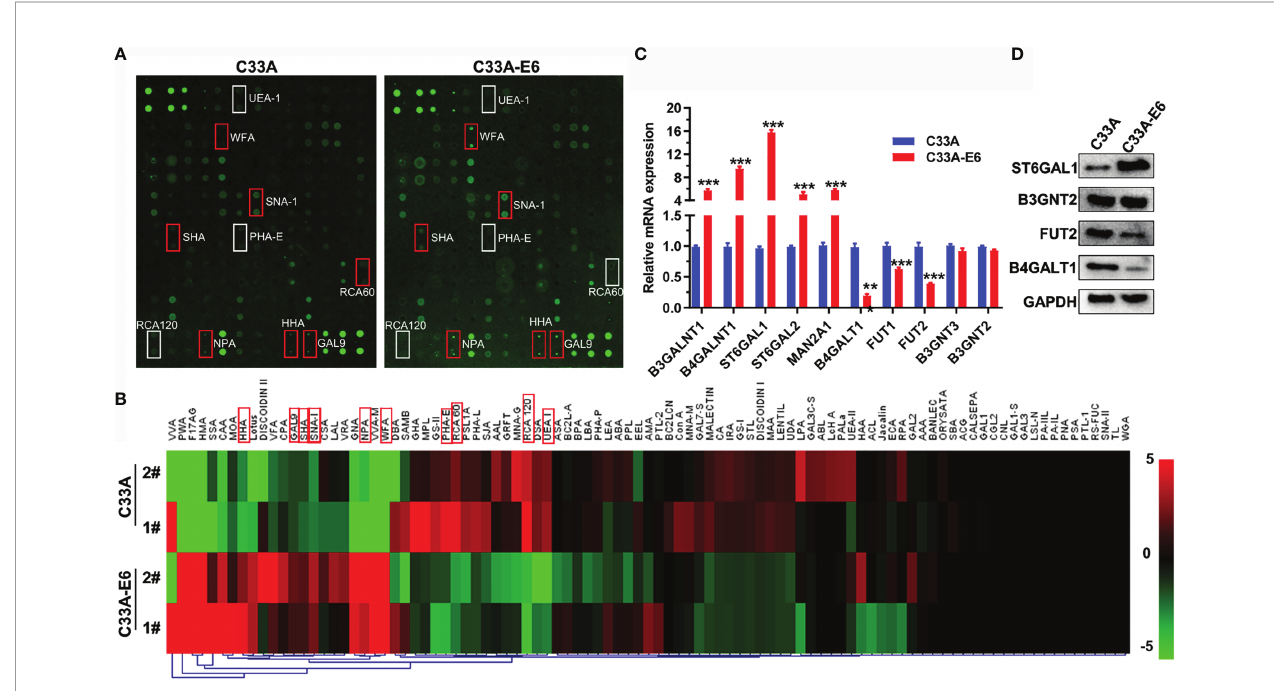
FIGURE 1 | The high-risk HPV16 E6 protein results in altered glycosylation in cervical cancer cells. (A) C33A cells were infected with pLVX-E6 or empty control pLVX lentivirus (MOI = 50) to select the stably transfected cells with the presence of puromycin (5 m g/ml). Then, glycosylation changes in whole-cell lysates of C33A and C33A-E6 cells (E6 stable expressing) were detected by lectin microarray (included 95 lectins). The slide with two replicates of the lectin array is shown. The lectin microarrays with high fl uorescence intensities in C33A-E6 cells are marked with red frames, and low fl uorescence intensities in C33A-E6 cells are marked with white frames. (B) Fluorescence intensities of samples from C33A and C33A-E6 cells were scanned and analyzed. Heat map and hierarchical clustering analysis of the 95 lectins with two biological replicates were presented. The signi fi cant different lectins were marked with red frames. (C) qRT-PCR was performed to detect the